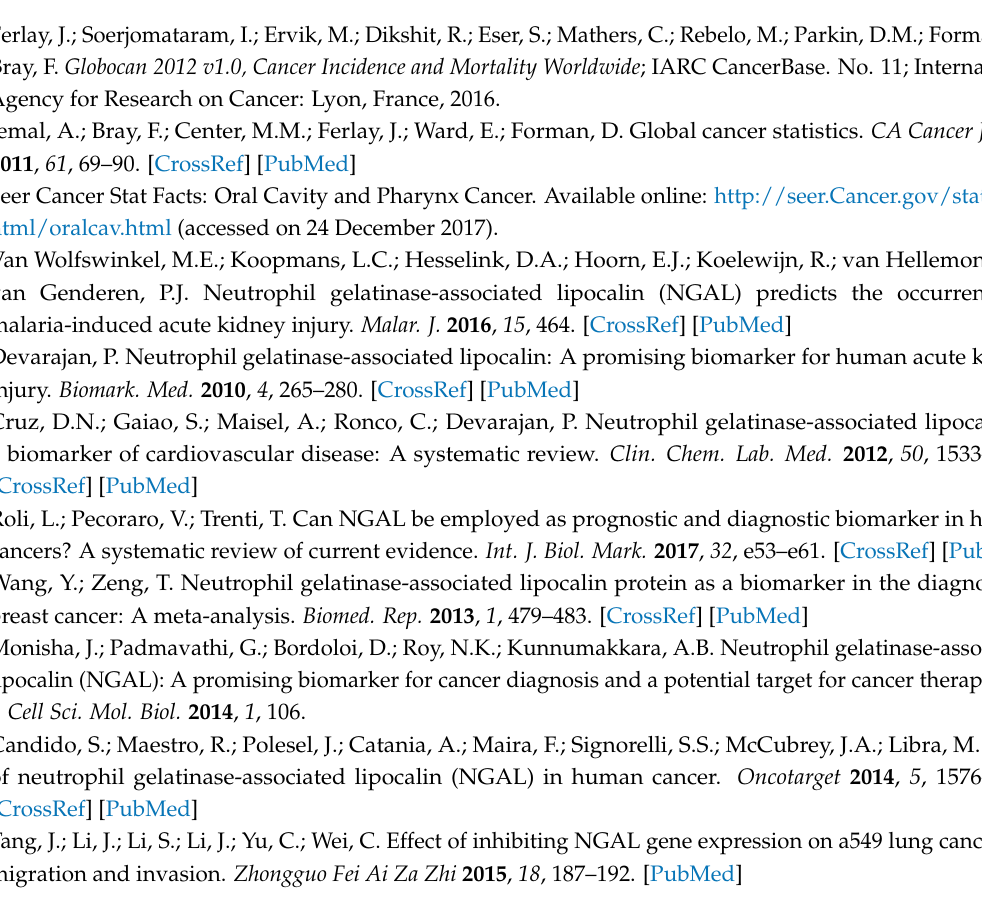
Figure S1: Expression of NGAL in different stages of the development of oral cancer. CAT: Cancer adjacent tissue. Mean composite score of NGAL levels in Normal tissues ( n = 10), inflammation ( n = 5), hyperplasia ( n = 5), cancer adjacent tissues ( n = 5), malignant tissues ( n = 42), and metastatic tissues ( n = 4). Data are mean ± SE. * = p < 0.05. Figure S2: Expression of NGAL in different types of oral cancer. Mean composite score of NGAL levels in NT-Normal tissue ( n = 10), MEC-Mucoepidermoid carcinoma ( n = 8), ACC-Adenoid cystic carcinoma ( n = 3), BCC-Basal cell carcinoma ( n = 2), SCC-Squamous cell carcinoma ( n = 28), and MSCC-Metastatic squamous cell carcinoma ( n = 4) of oral cancer. Data are mean ± SE. * = p < 0.05. Figure S3: Expression of NGAL with age and gender in oral cancer tissues. (A) Mean composite score of NGAL levels in tissues from normal male ( n = 11), normal female ( n = 10), malignant male ( n = 100), and malignant female ( n = 39) patients with oral cancer. (B) Mean composite score of NGAL levels in normal ( n = 17) and malignant oral cancer patient tissues of age groups 0–30 year ( n = 4), 30–45 year ( n = 18), 45–60 year ( n = 63), and 60–100 year ( n = 52). Data are mean ± SE. * = p <